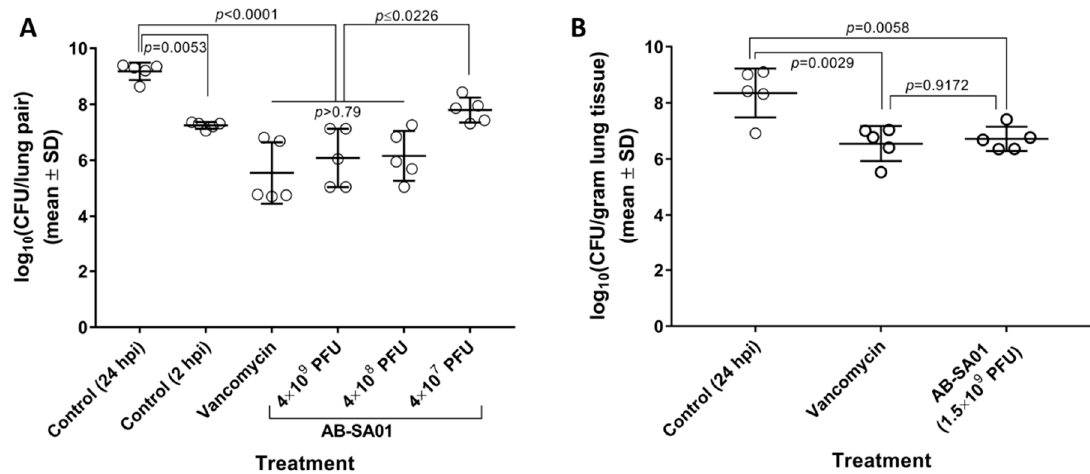
Figure 3. AB-SA01 reduces lung bacterial burden in ( A ) neutropenic CD-1 mice and ( B) immunocompetent BALB/c mice . Phage doses are given as total plaque-forming units (PFU) per